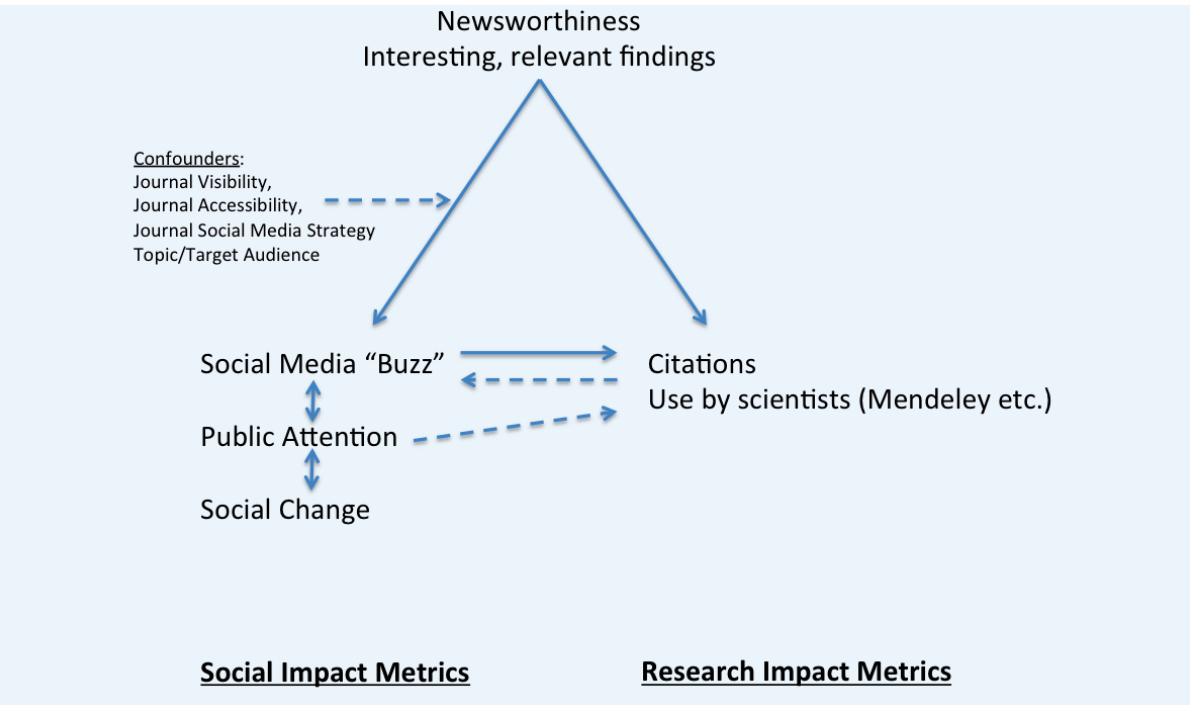
Figure 12. Model of the relationship between social impact and research impact